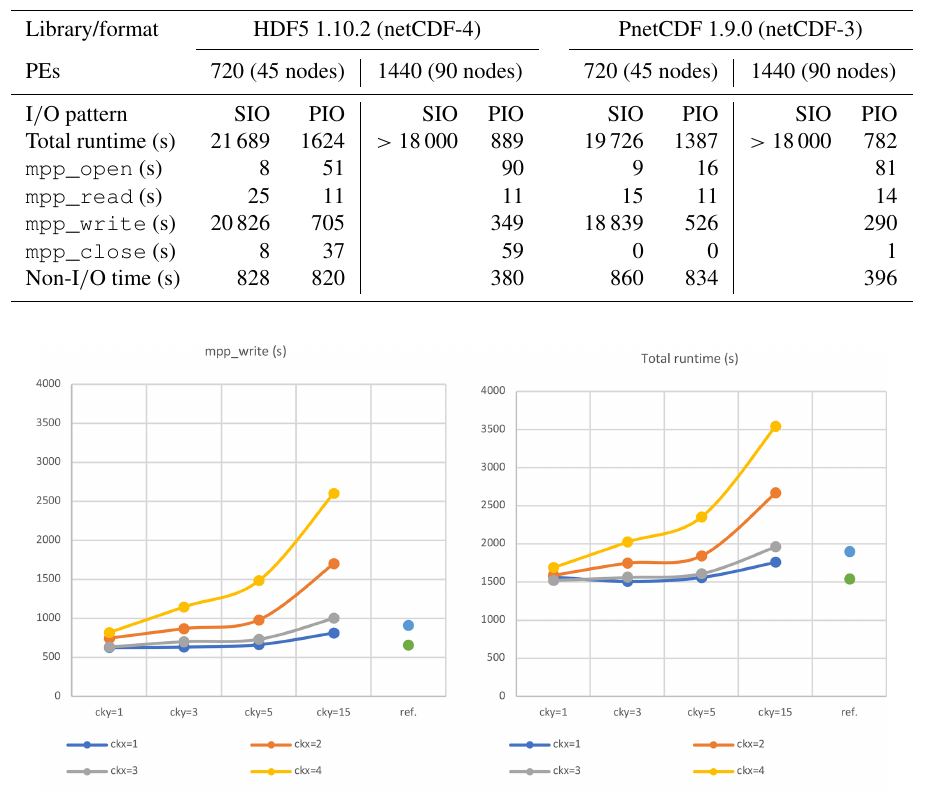
Table 5. The time metrics of 0.1 ◦ model in 720 and 1440 PE runs with HDF5 1.10.2/netCDF-4 and PnetCDF 1.9.0/netCDF-3. SIO represents the original serial read and single-threaded write; PIO represents the serial read and parallel shared write. All values are taken from the maximum wall time among all PEs.